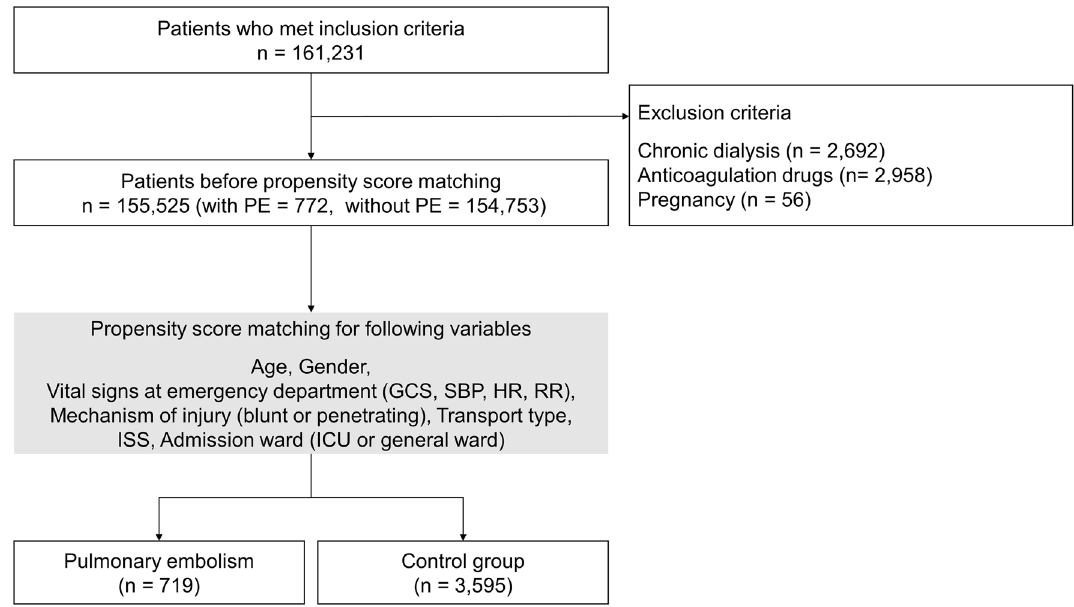
Figure 1. Patient selection. Definition of abbreviations: PE = pulmonary embolism; ISS = Injury Severity Score; GCS = Glasgow Coma Scale; SBP = systolic blood pressure; HR = heart rate; RR = respiratory rate; ICU = intensive care